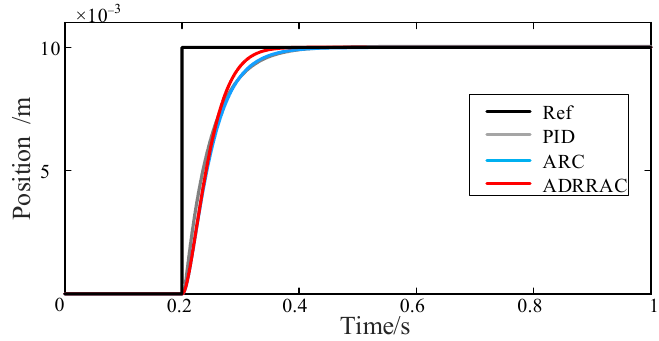
Figure 16. Tracking Performance of 10 mm Step Signal. Table 2. Performance indicators of 1 Hz sinusoidal inputs.